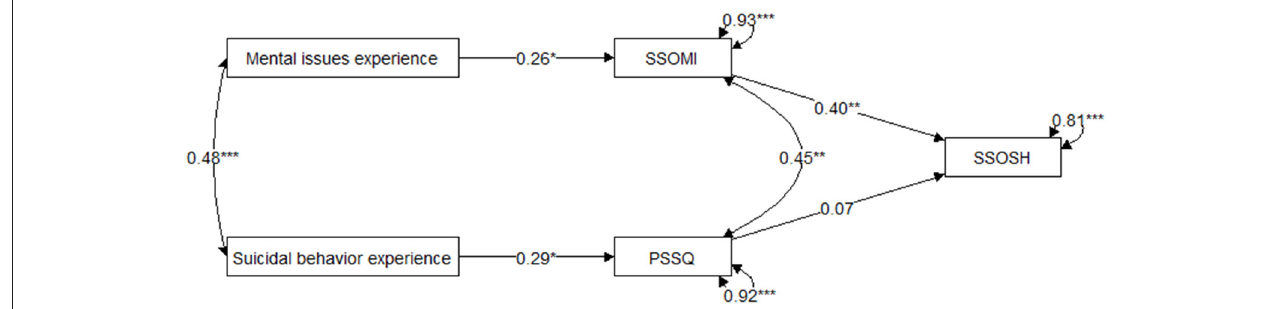
FIGURE 1 | Model Predicting Anticipated Help-Seeking Self-Stigma Based on Personal History Variables With Anticipated Self-Stigma for Mental Illness and Anticipated Public Stigma for Suicidal Behavior as Mediators. PSSQ, the Personal Suicide Stigma Questionnaire (anticipation form) scale score; SSOMI, the Self-Stigma of Mental Illness scale score; SSOSH, the Self-Stigma of Seeking Help scale score. * p < 0.05. ** p < 0.01. *** p < 0.001.